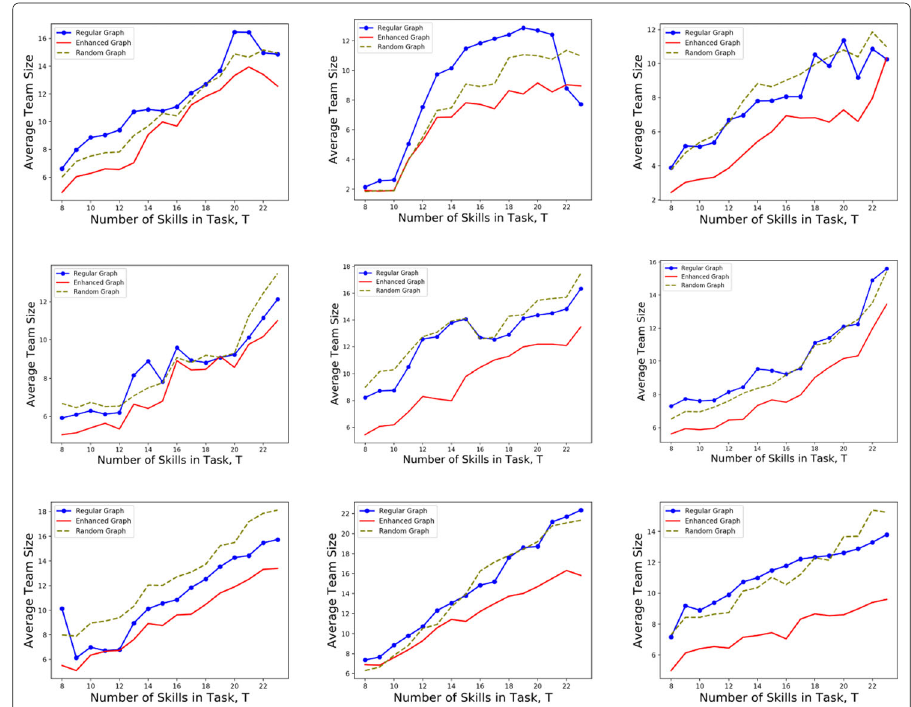
Fig. 11 Average Cardinality of Teams for Differing Task Sizes — Samsung